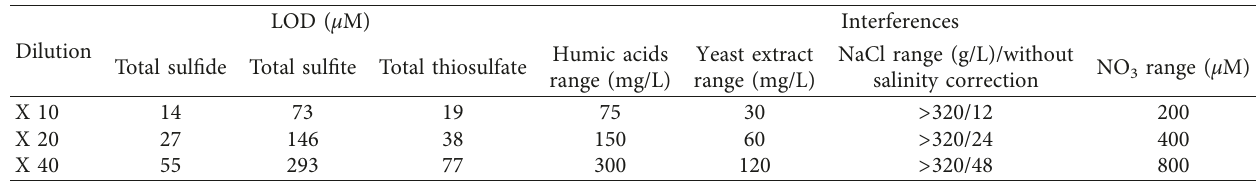
Table 2: Limit of detection (LOD) obtained for total sulfide, sulfite, and thiosulfate as a function of sample dilution, salinity, and concentrations of humic acids, yeast extract, and nitrate for which first interferences with sulfur compounds